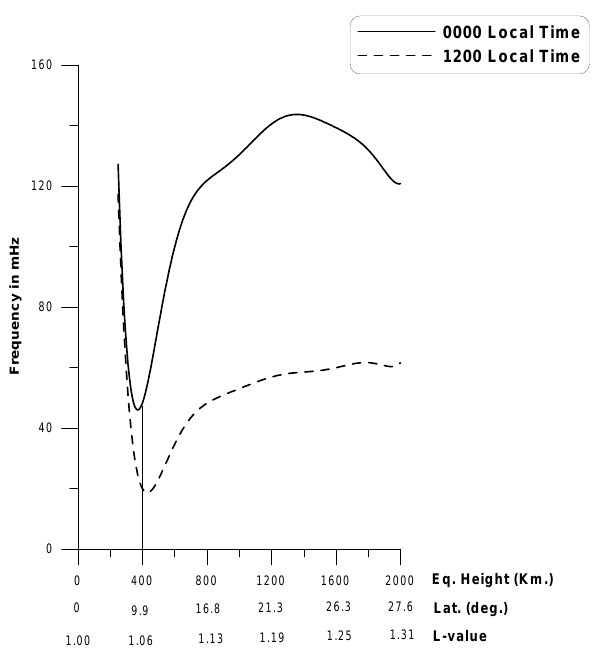
Fig. 1. Fundamental toroidal frequency as a function of equato- rial height. Corresponding geomagnetic latitudes and L-values are marked. The period of oscillation for the field line with an equato- rial height of 400 km has been shown by the vertical line.